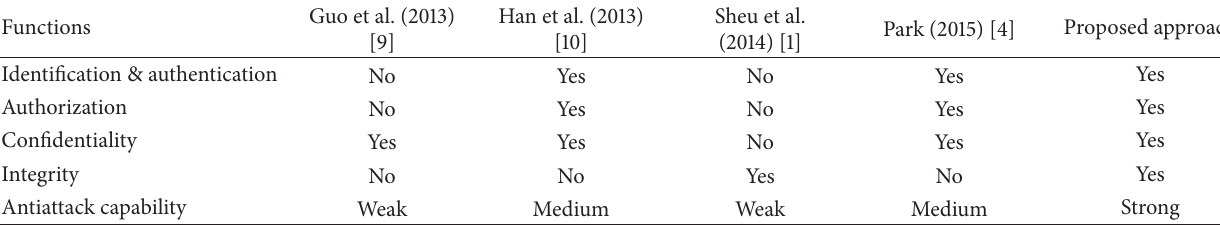
Table 1: Performance